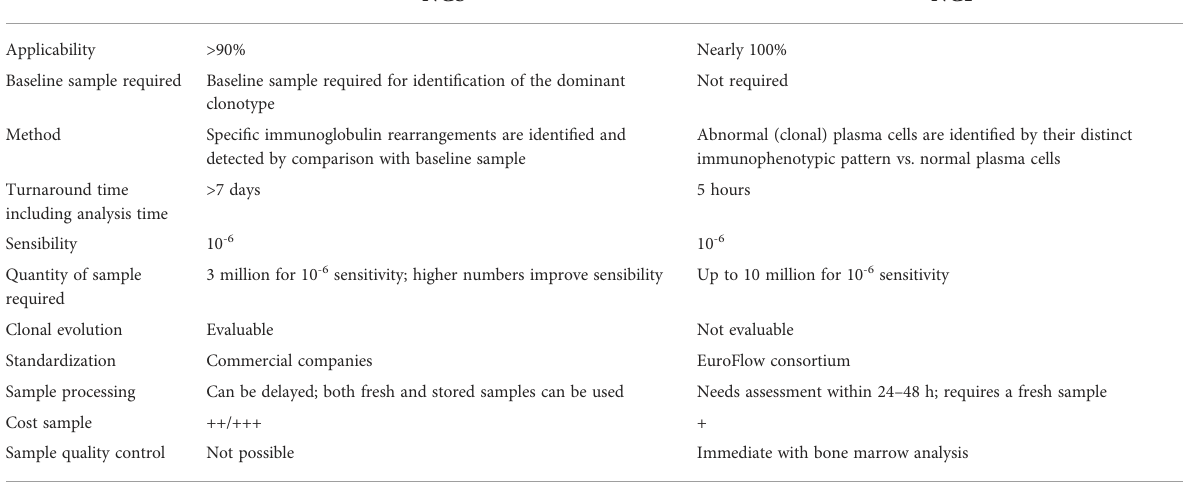
TABLE 1 Comparison of NGS and NFG for assessment of MRD in multiple